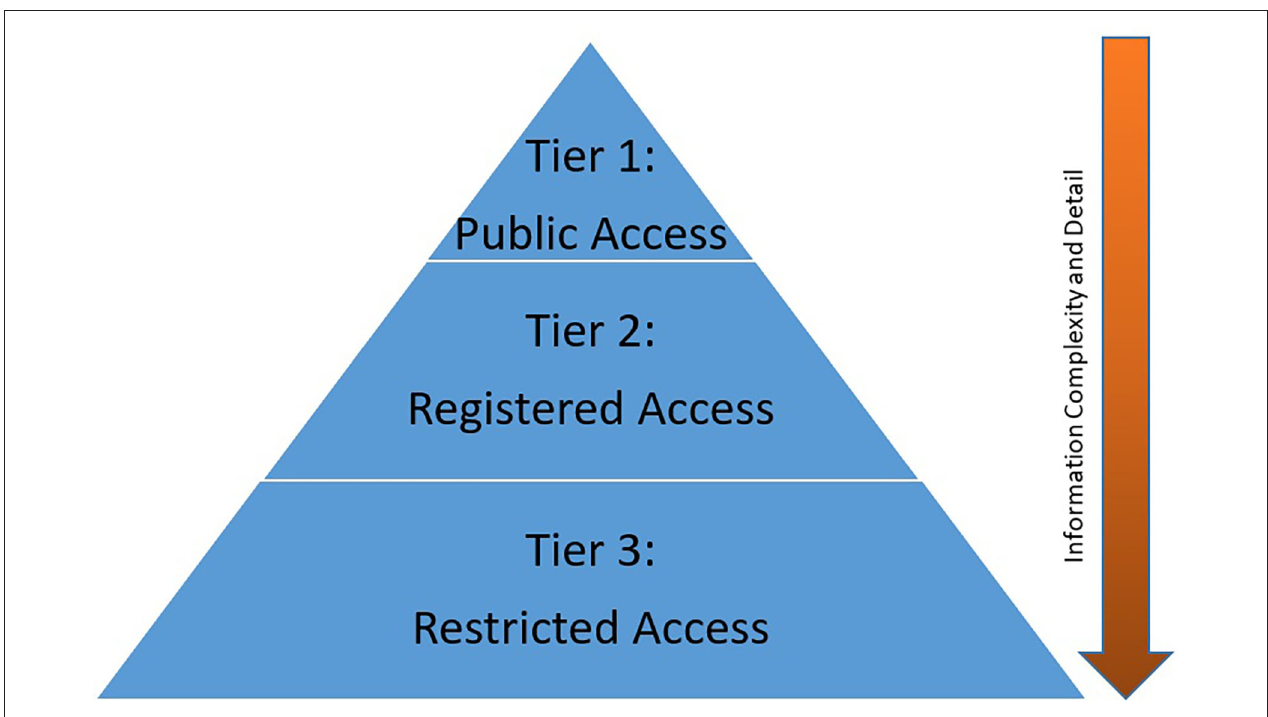
FIGURE 3 | NCSA Model Access Tiers.